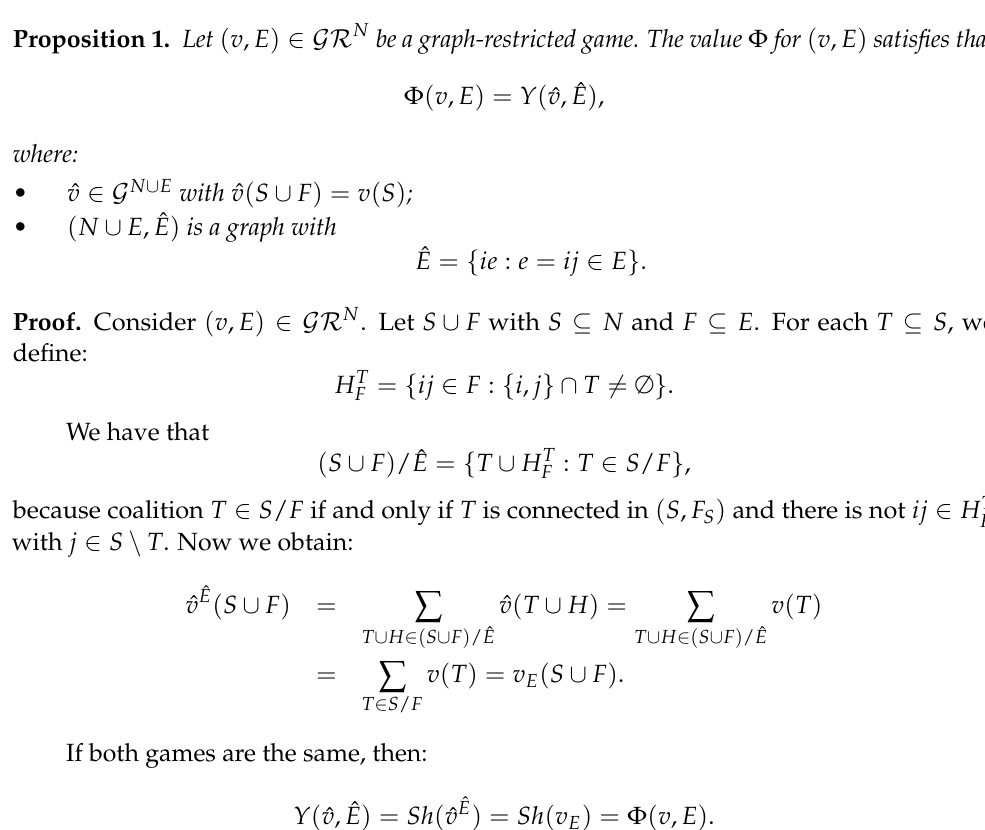
Figure 2. Graph involving vertices and